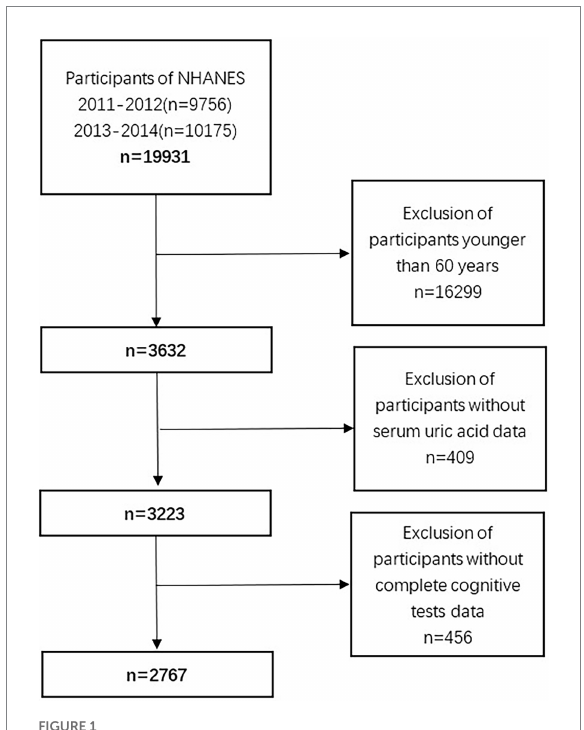
FIGURE 1 Flow chart of the procedure for selecting eligible